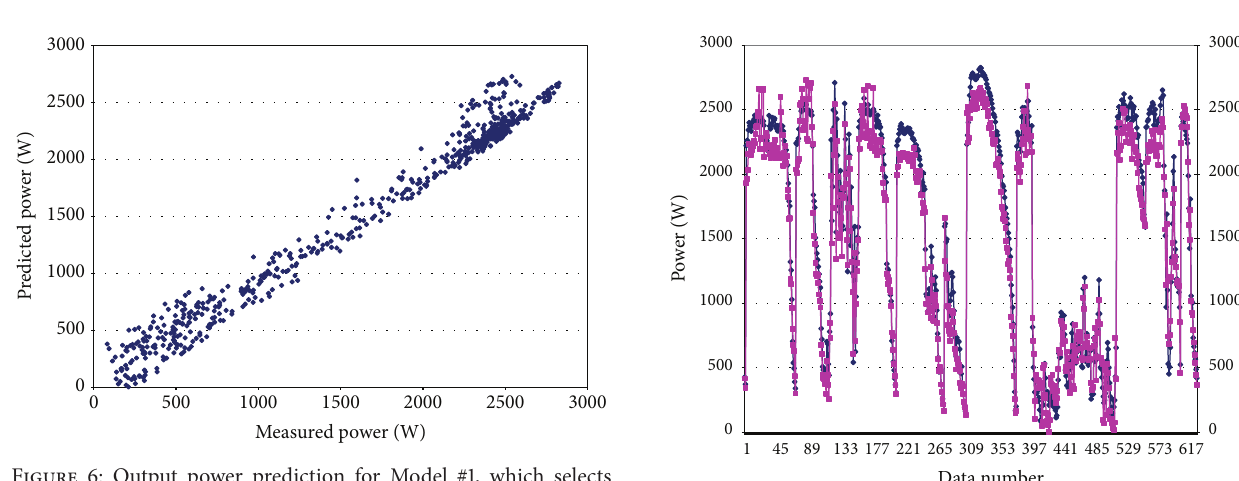
Figure 5: The method of determining the amount of power generated if the panel is not affected by clouds.